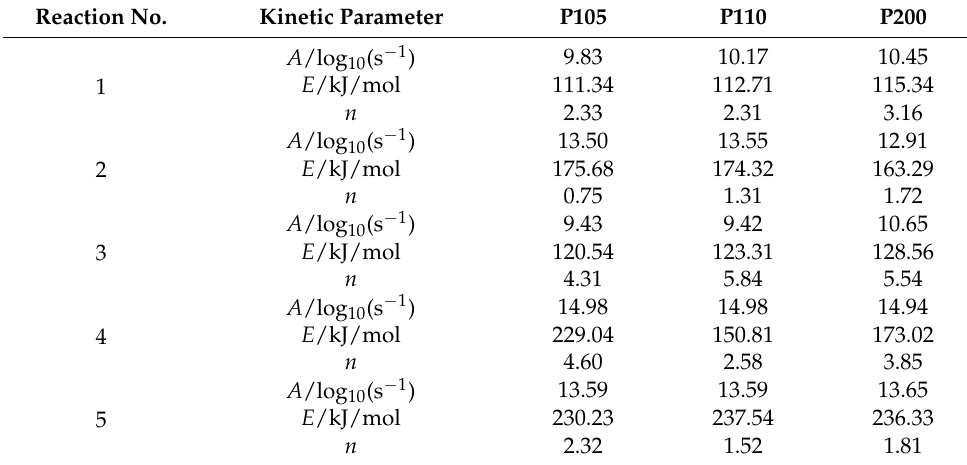
Table 4. Kinetic triplets of PUs calculated by GA